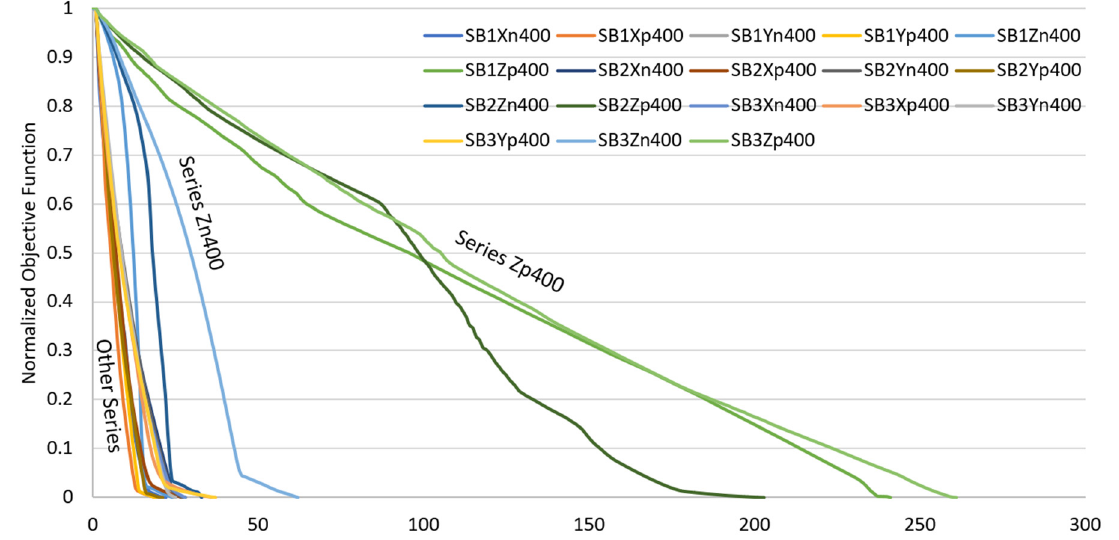
Figure 10. Convergence history for 18 shape change analysis cases in the uni-directional mode with target displacement of 400 mm.